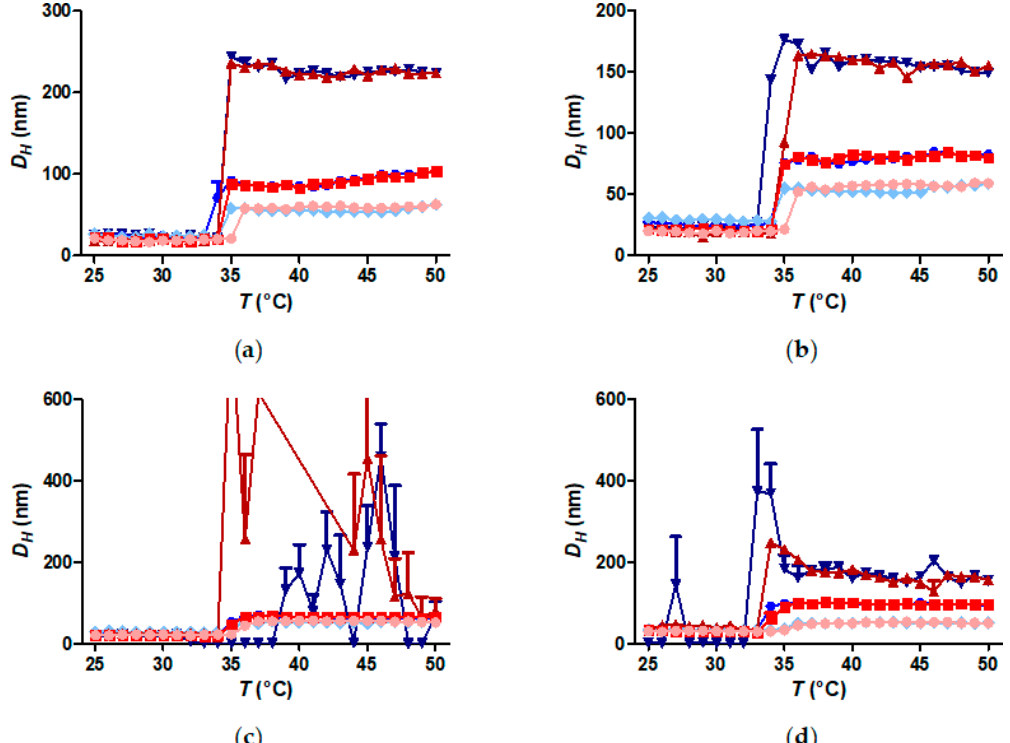
Figure 4. Temperature-cycled average hydrodynamic size measured by dynamic light scattering of PiPOx (26 kDa)-grafted iron oxide nanoparticles at different concentrations. Heating curves are depicted in red colours, while cooling curves are depicted in blue colours. Light red and light blue: polymer concentration: 0.1 g L − 1 , red and blue: polymer concentration: 1 g L − 1 and dark red and dark blue: polymer concentration: 10 g L − 1 . ( a ) FeOx-5; ( b ) FeOx-7; ( c ) FeOx-10; ( d ) FeOx-21.